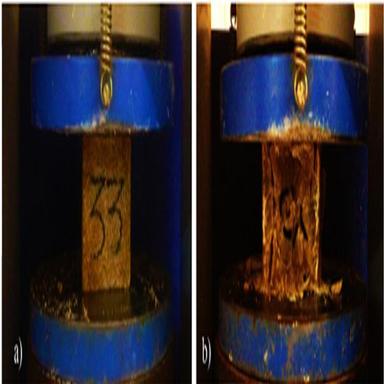
Compression test (a) intact vs. (b) broken specimen.